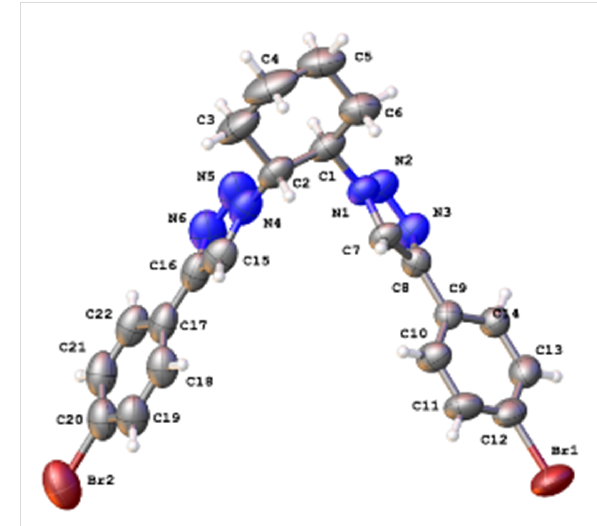
Figure 3: ORTEP representation of the molecular structure of com- pound 12 ( trans configuration) obtained from X-ray diffraction data.